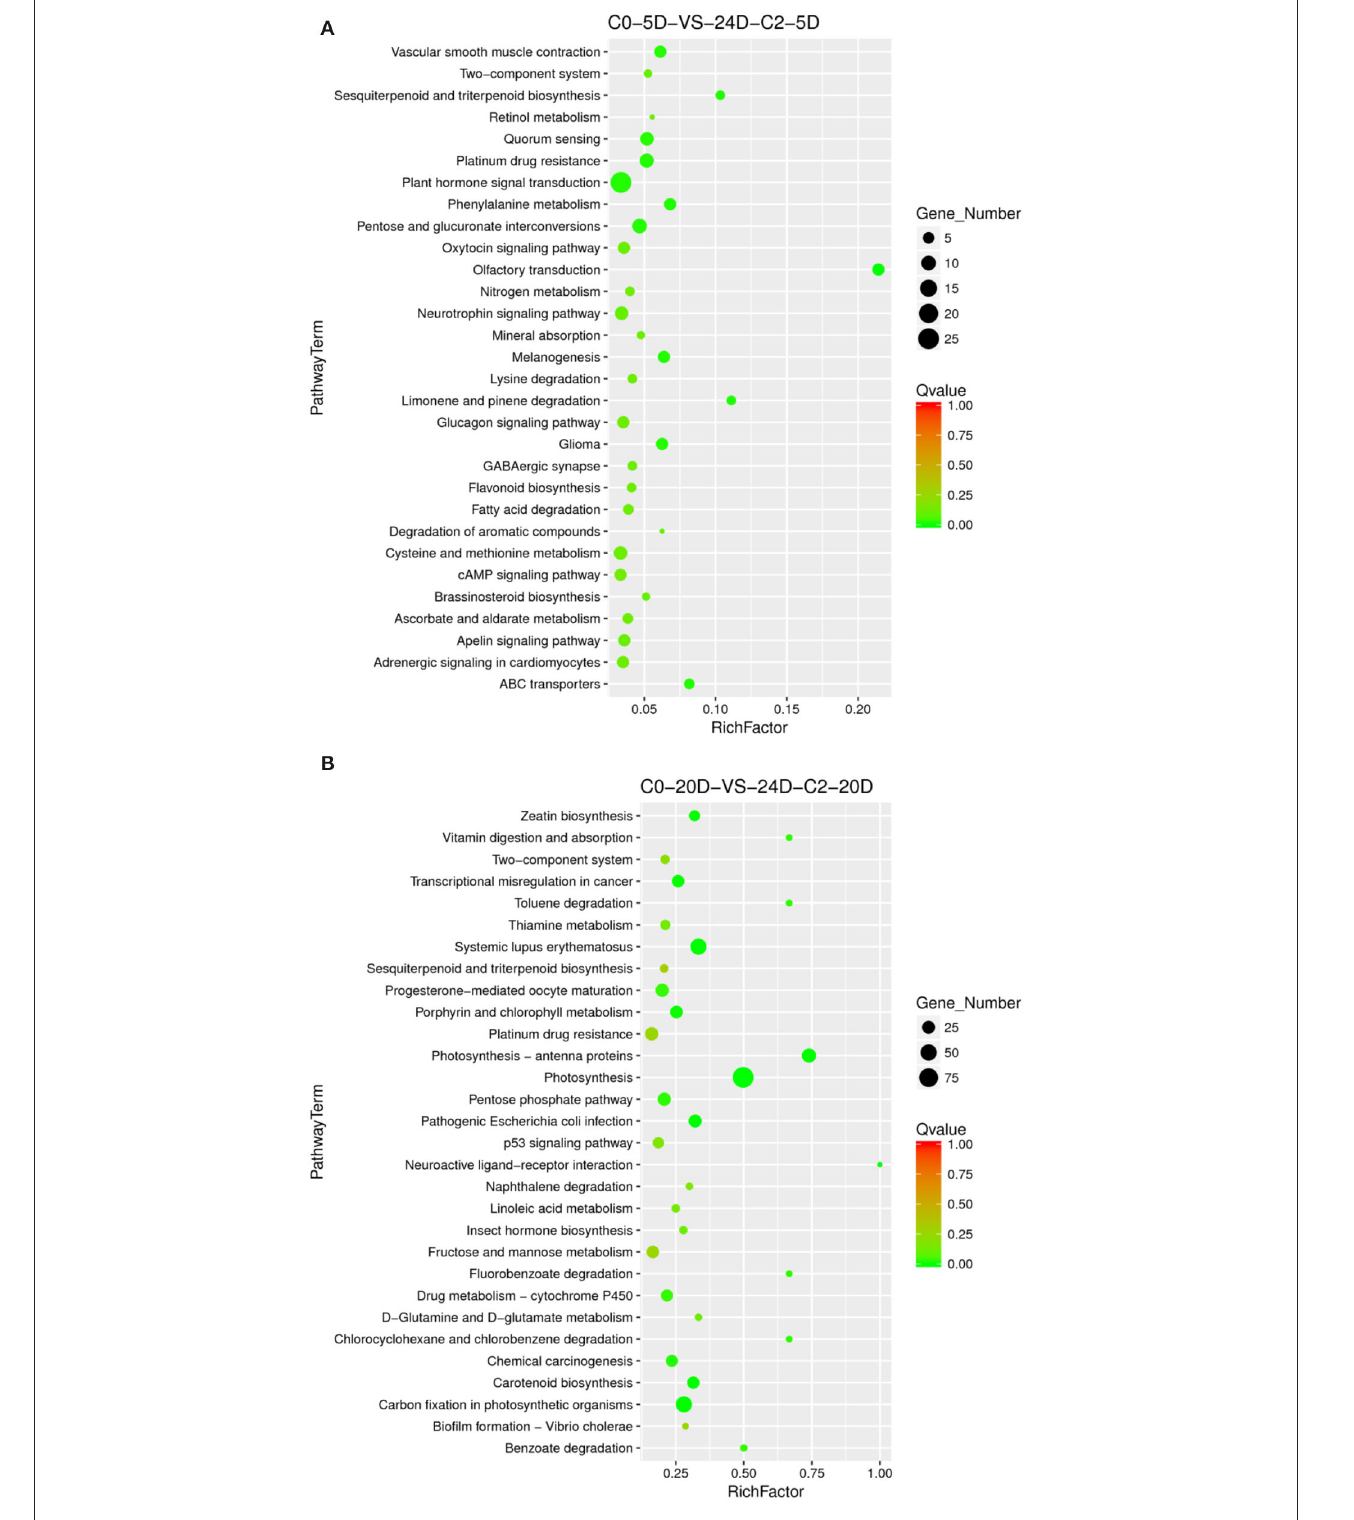
FIGURE 6 | The KEGG enrichment of DEGs in comparison groups under the 2,4-D induction effect. (A) Pathways enriched in C0-5D vs. 24D-C2-5D; (B) Pathways enriched in C0-20D vs. 24D-C2-20D. 24D, 2,4-dichlorophenoxyacetic acid; C0, 0mg L − 1 ; C2, 0.05mg L − 1 ; 5D, 5 days’ treatment; 20D, 20 days’ treatment.